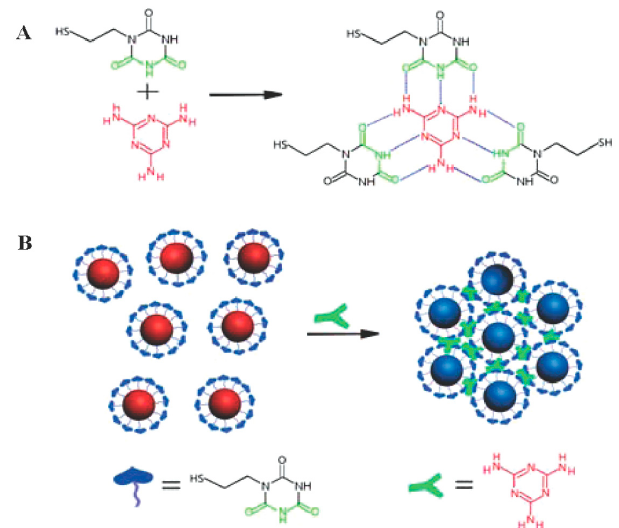
Figure 17. ( A ) Hydrogen-bonding recognition between melamine and cyanuric acid derivative. ( B ) Colorimetric detection of melamine using the 1-(2-mercaptoethyl)-1,3,5-triazinane-2,4,6-trione (MTT)-stabilized gold nanoparticles (reproduced with permission from Reference [117]).